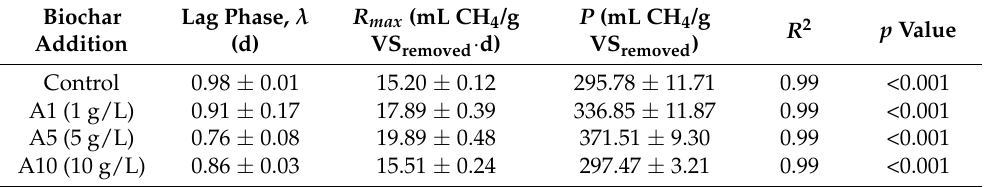
Table 1. Parameter values of modified Gompertz model fitted with the experimental